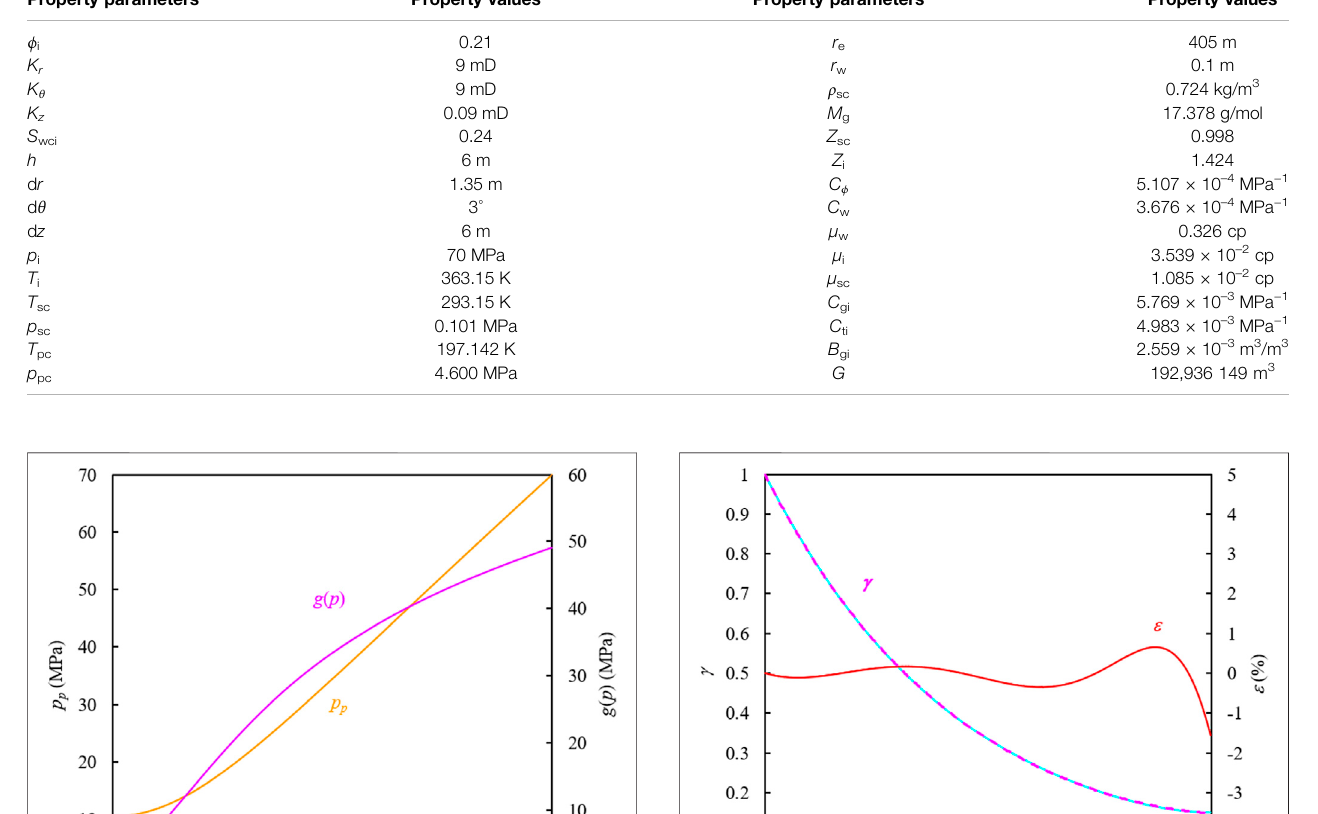
TABLE 1 | Property parameters for numerical simulations. Property parameters Property values